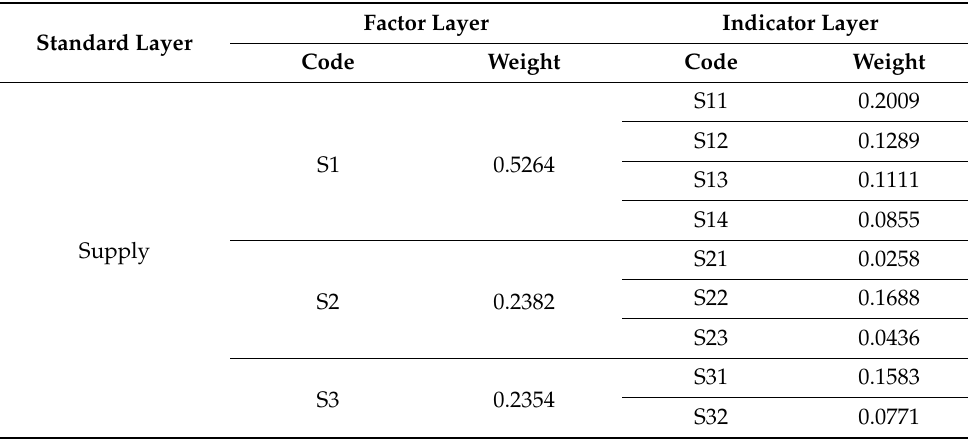
Table 4. Entropy weights of supply